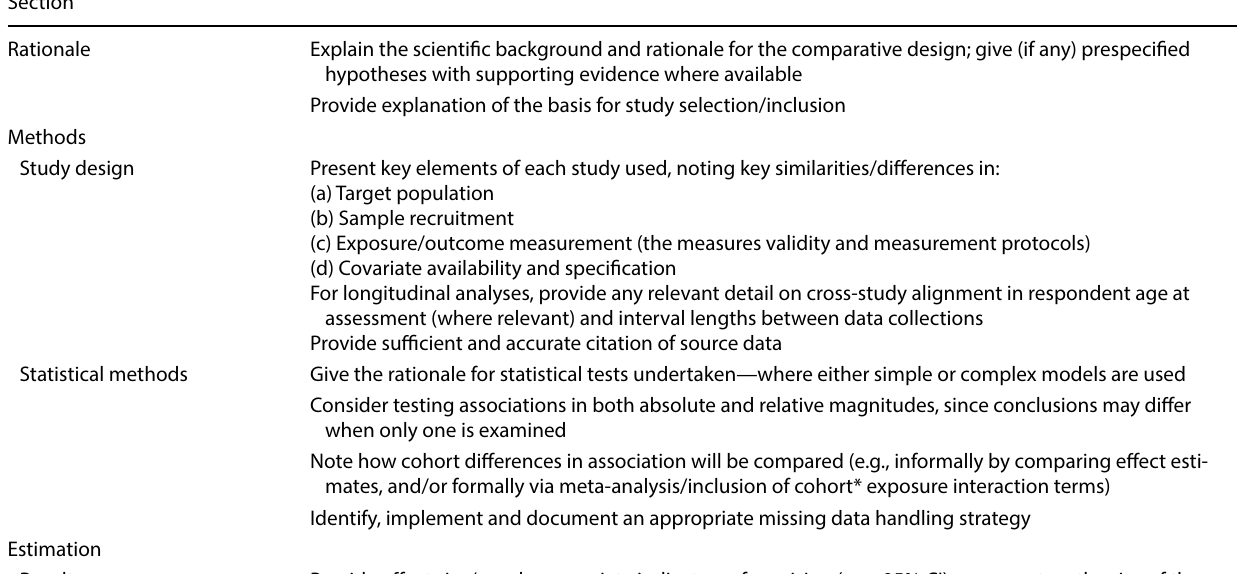
Table 1 Checklist for studies which investigate differences in prevalence or associations across time Domain